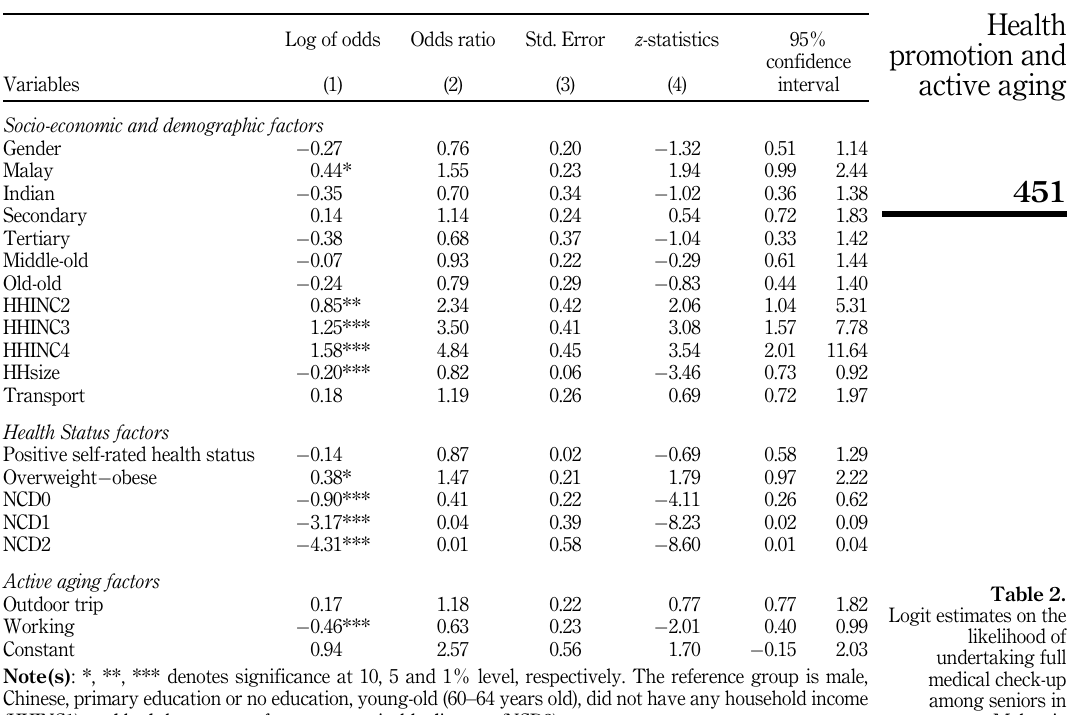
Table 2. Logit estimates on